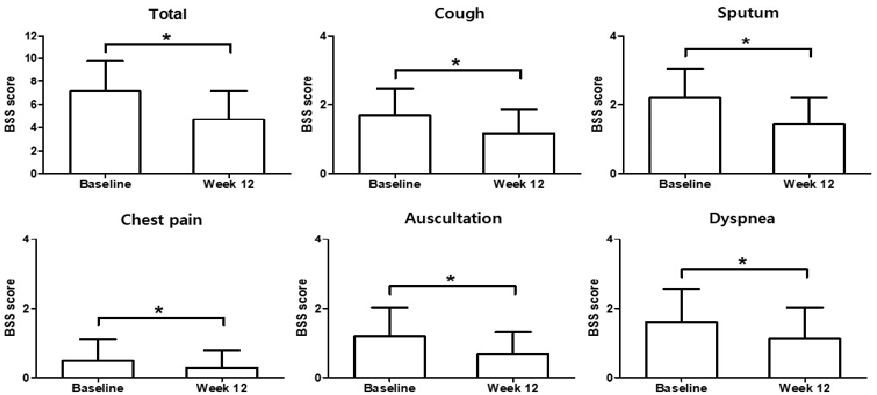
Figure 3. Change from baseline in bronchitis severity scores (BSS) total scores, cough, sputum production, chest pain, auscultation, and dyspnea. p -value < 0.0001 (Cf. Activity p -value: 0.0971) Wilcoxon’s signed-rank test. *: Statistically significant difference.